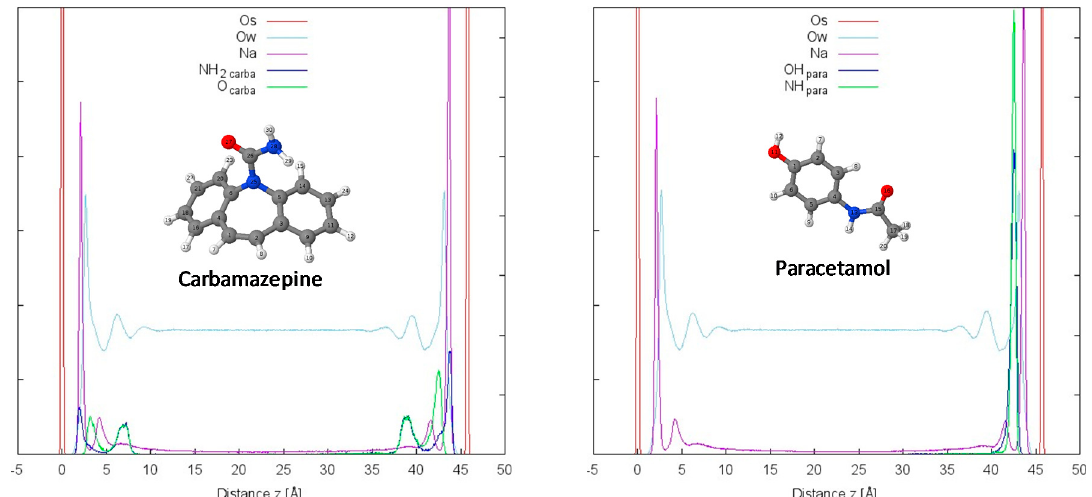
Figure 4. Density profiles (DPs) along the z -coordinate (interlayer separation orthogonal to basal surfaces). Surface oxygen (Os) DPs are in red, water oxygen (Ow) in light blue, and sodium cations in purple; for carbamazepine (left), the nitrogens are in blue and the oxygen is in green; for paracetamol (right), the hydroxyl oxygen is in blue and the nitrogen is in green. Table 1. Density profile data (see Figure 4). Peak coordinates (along z ) and densities are given in Å. In parentheses, the percentage of the total atom/molecule density is reported.